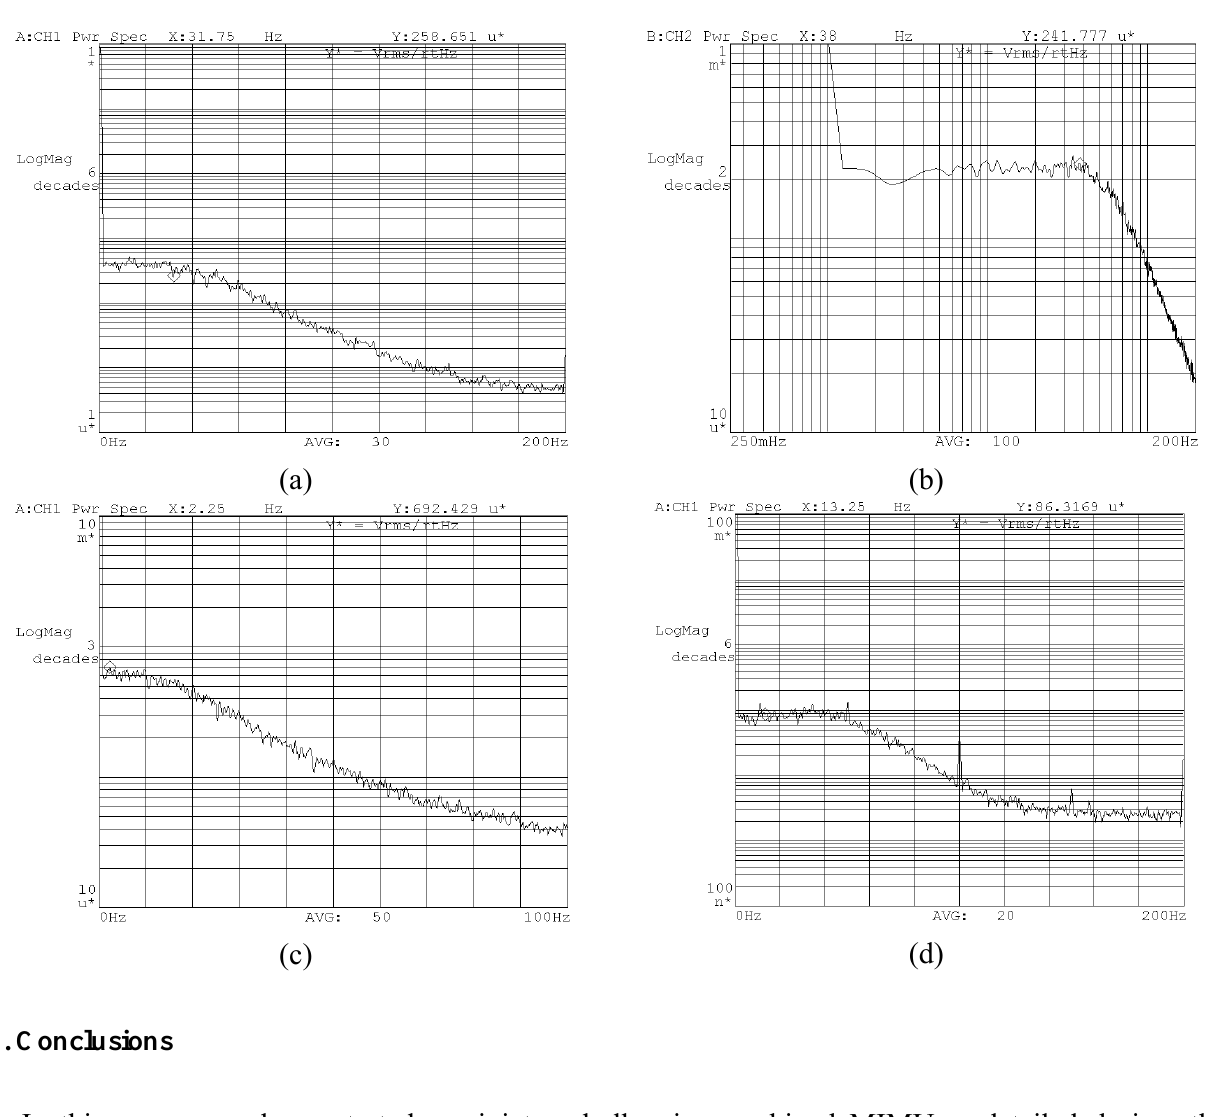
Figure 18. The noise floors of the six sensors in the MIMU. (a) X/Y-axis accelerometer; (b) Z-axis accelerometer; (c) X/Y-axis gyroscope ; (d) Z- axis